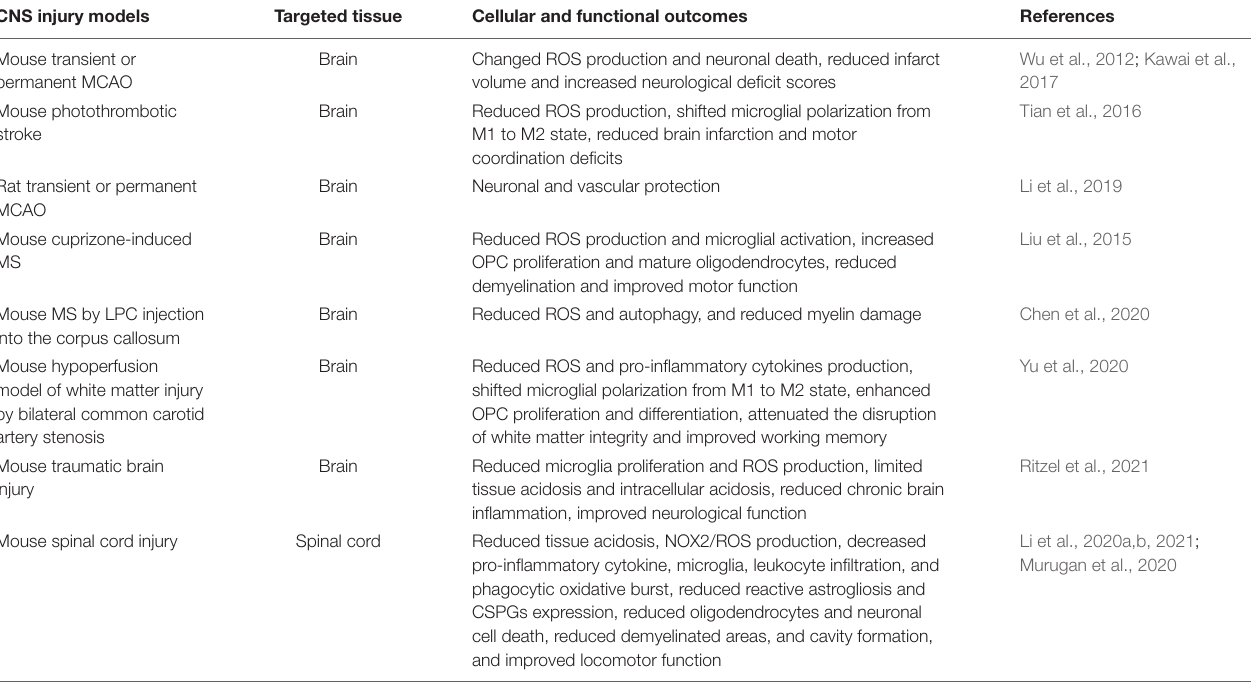
TABLE 1 | Therapeutic effect of Hv1 deficiency (Hv1 knockout) in various animal models.